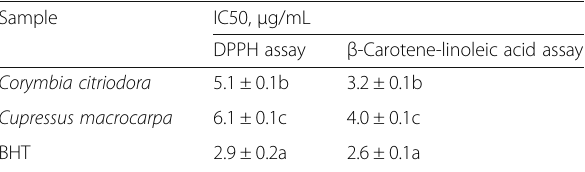
Table 4 Essential oils DPPH and β -carotene-linoleic acid